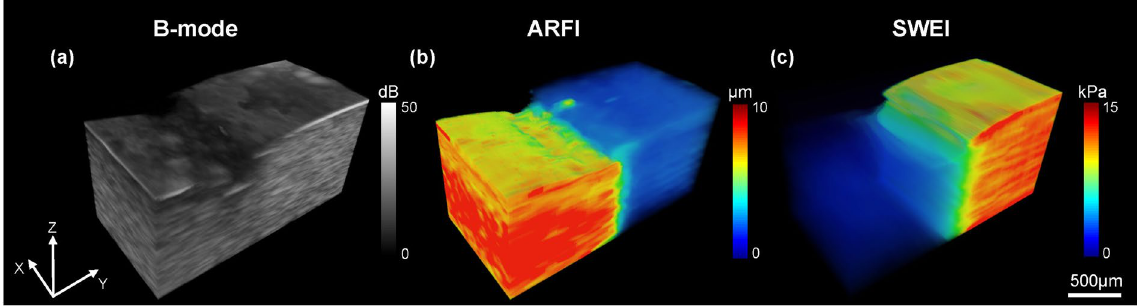
Figure 4. 3D visualizations of a side by side gelatin tissue-mimicking phantom. ( a ) B-mode image, ( b ) ARFI image and ( c ) SWEI image. Volume dimensions (xyz) are 1.8 mm × 3.6 mm × 2